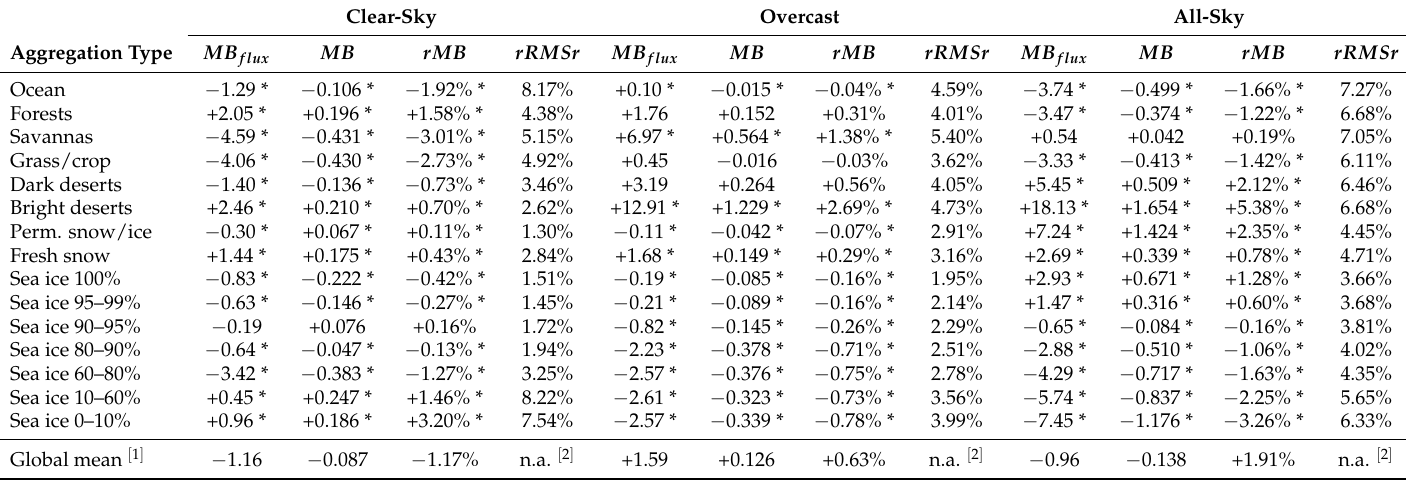
Table A2. Generic surface-type-independent regression performance based on expanded database (with relaxed matching criteria), stratified per surface type, for clear, overcast, and allsky conditions; Data: 2004–2005 (NOAA17+Terra), 2007–2008 (NOAA18+Aqua) and 2011–2012